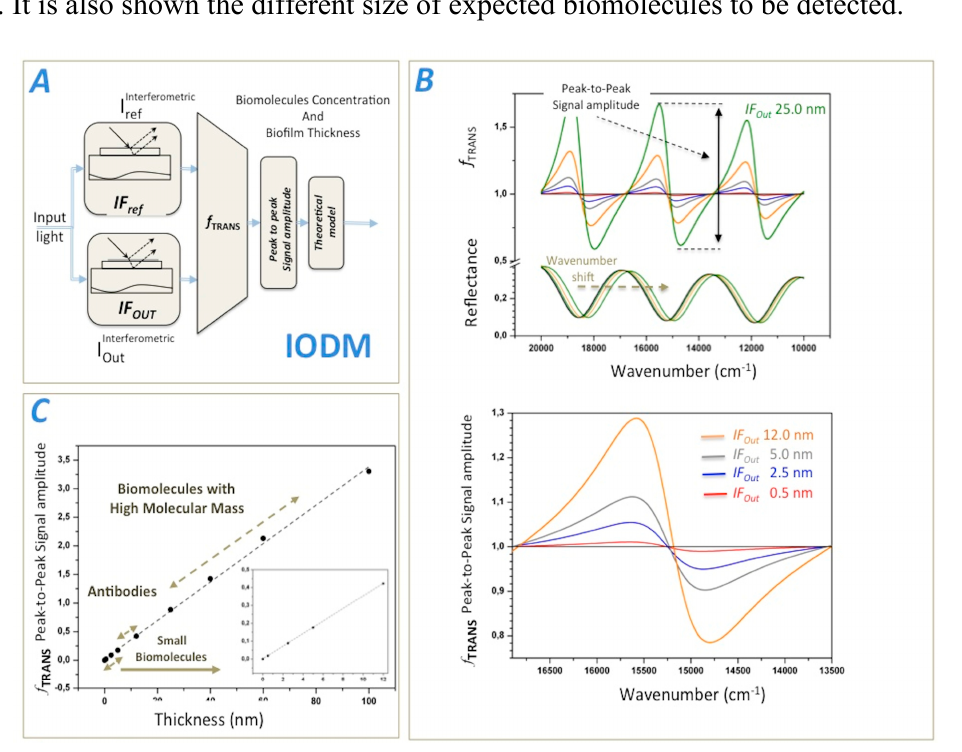
Figure 1. ( A ) Description of the Interferometric Optical Detection Method (IODM) particularized for a Fabry-Perot interferometer based on a SiO 2 thin layer over Si as transducer model, ( B ) Optical simulation of the transduction function f TRANS coming from the reflectance optical response of IF Out for different biofilms thicknesses, ( C ) Theoretical sensing response considering the peak-to peak signal amplitude of f TRANS as transducing signal. It is also shown the different size of expected biomolecules to be